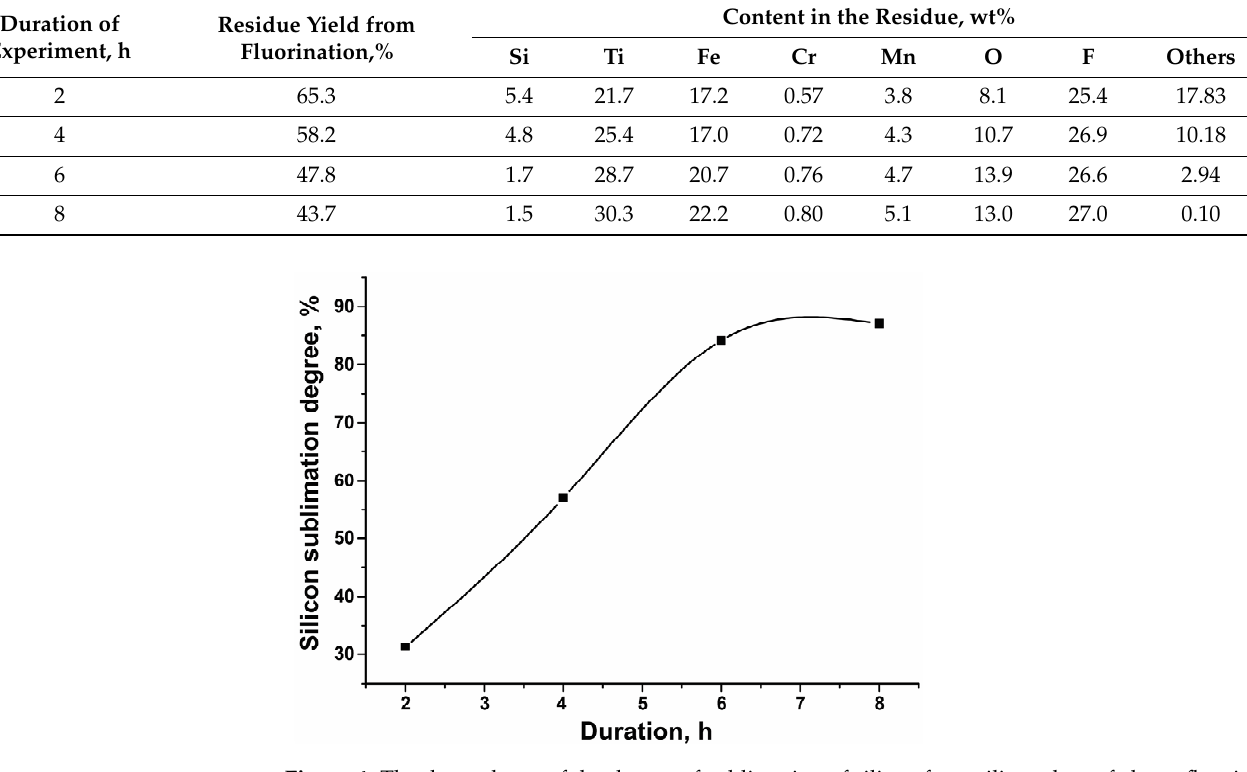
Table 3. Results of fluorination of electrosmelting dust of ilmenite concentrate. Influence of the process duration.